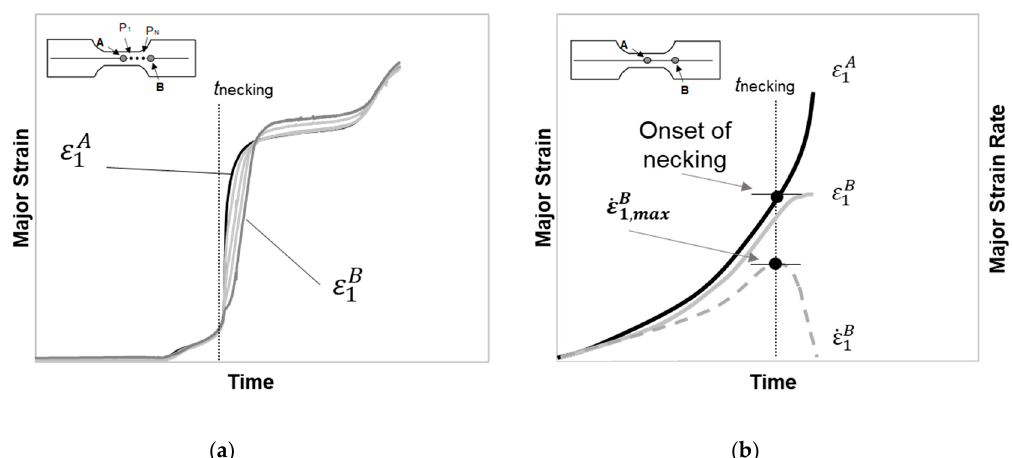
Figure 1. Schematic representation of the major strain and major strain rate evolution with time for a polycarbonate Nakajima test with pure tension geometry. ( a ) Evolution of major strains with time for the necking region, ( b ) Time-dependent approach application, adapted from Martínez-Donaire et al. [31].